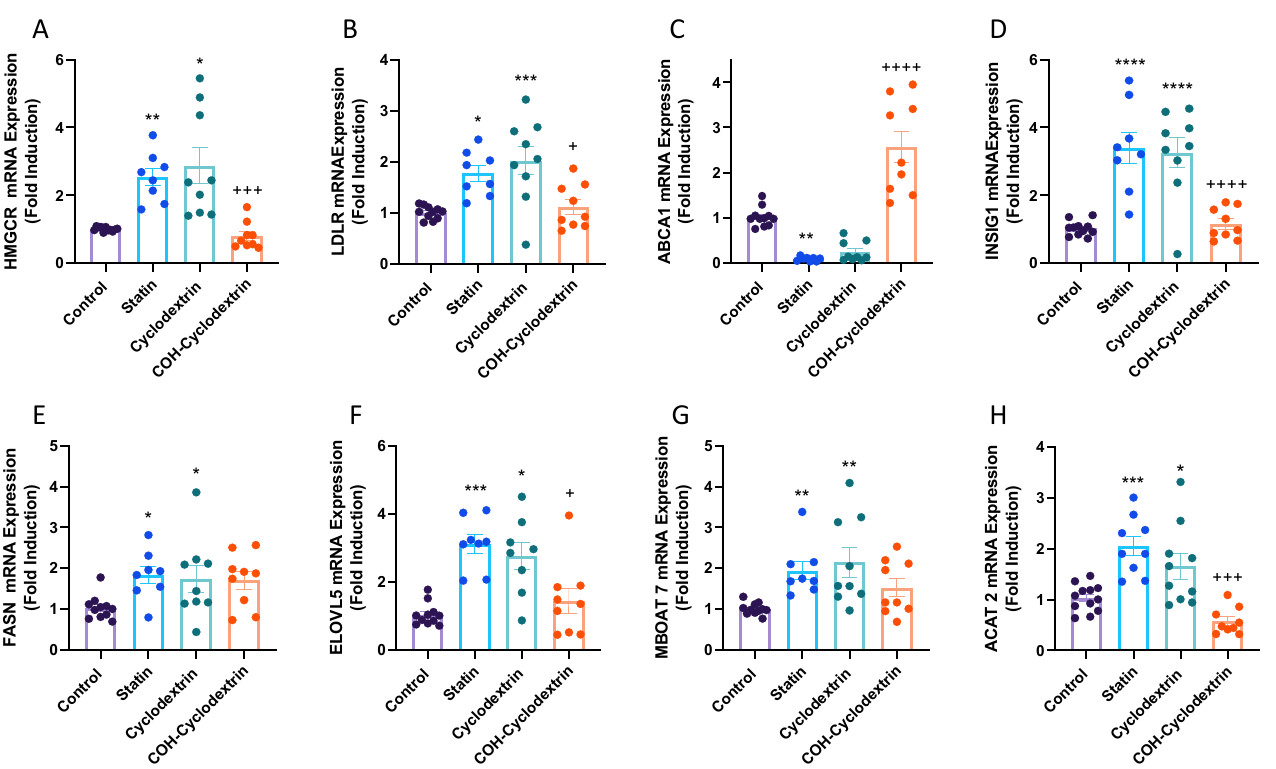
Figure 4. Expression of lipid regulating genes in response to cholesterol modulating treatments in Hep3B cells: ( A ) HMGCR ; ( B ) LDLR ; ( C ) ABCA1 ; ( D ) INSIG1 ; ( E ) FASN ; ( F ) ELOVL5 ; ( G ) MBOAT7 and ( H ) ACAT2 mRNA expression relative to RPLP0 and expressed as fold change over control. Data are presented as mean ± SEM ( n = 3/group with 2–4 technical replicates per experiment). Data were assessed for normality using a Shapiro–Wilk test and analysed using one-way ANOVA with Tukey post hoc testing for multiple comparisons. Non-parametric data was analysed using the Kruskal–Wallis test with Dunn’s multiple comparison test. * p < 0.05, ** p < 0.01, *** p < 0.001, **** p < 0.0001 vs. control; + p < 0.05, +++ p < 0.001, ++++ p < 0.0001 vs. statin. Abbreviations: HMGCR , 3-hydroxy-3-methylglutaryl-CoA reductase; LDLR , low density lipoprotein receptor; ABCA1 , ATP-binding cassette transporter 1; INSIG1 , insulin-induced gene 1 protein; FASN , fatty acid synthase 1; ELOVL5 , elongation of very long-chain fatty acids protein; MBOAT7, membrane bound O-acyltransferase domain containing 7; ACAT2, acetyl-CoA acetyltransferase